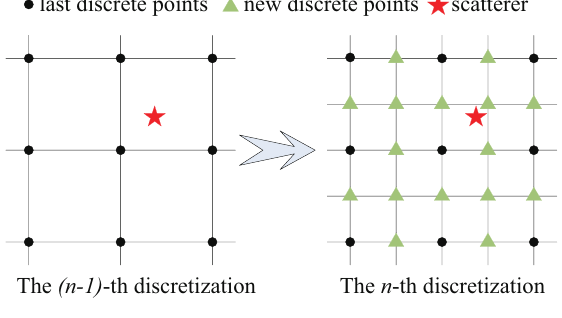
Figure 4. Grid refinement